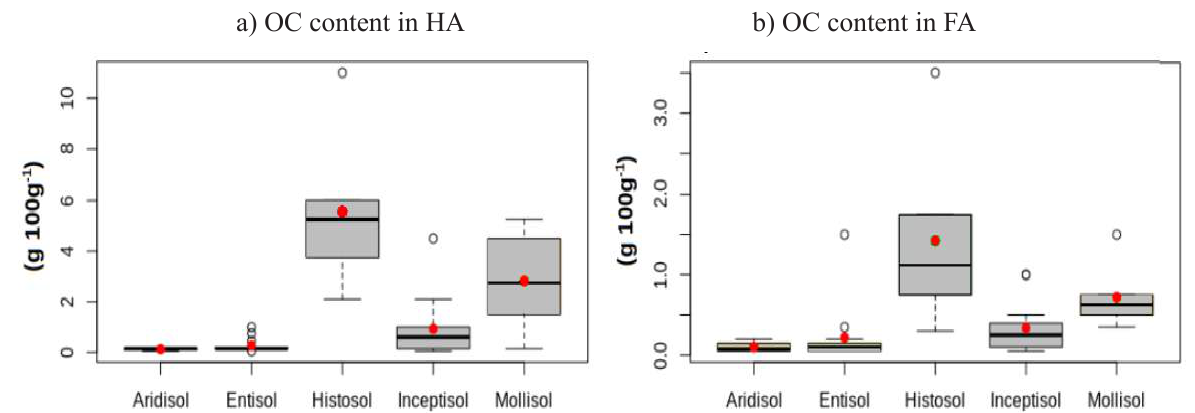
Figure 3: Box plots of carbon content from humic acids (a) and fulvic acids (b) in five soil orders.